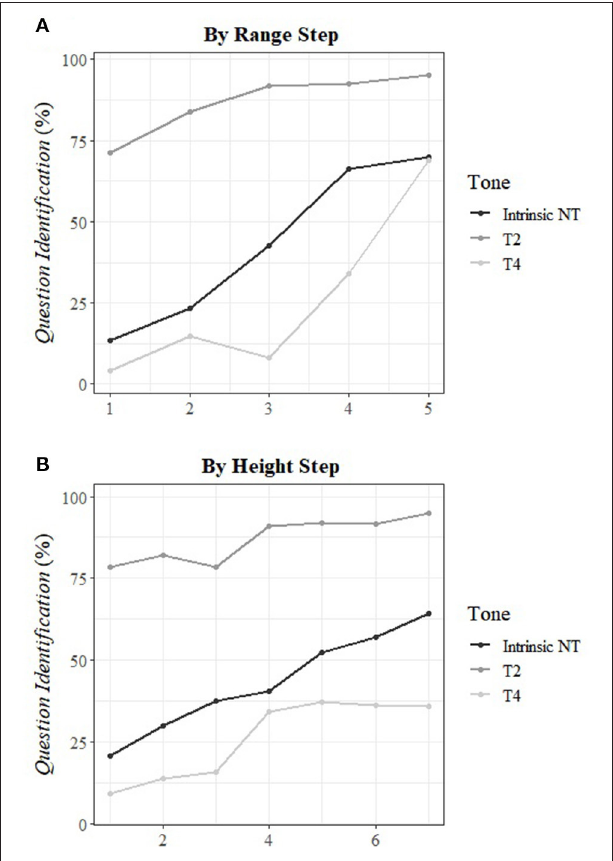
of B ′′ reflects the perceptual bias. The smaller it is, the better D